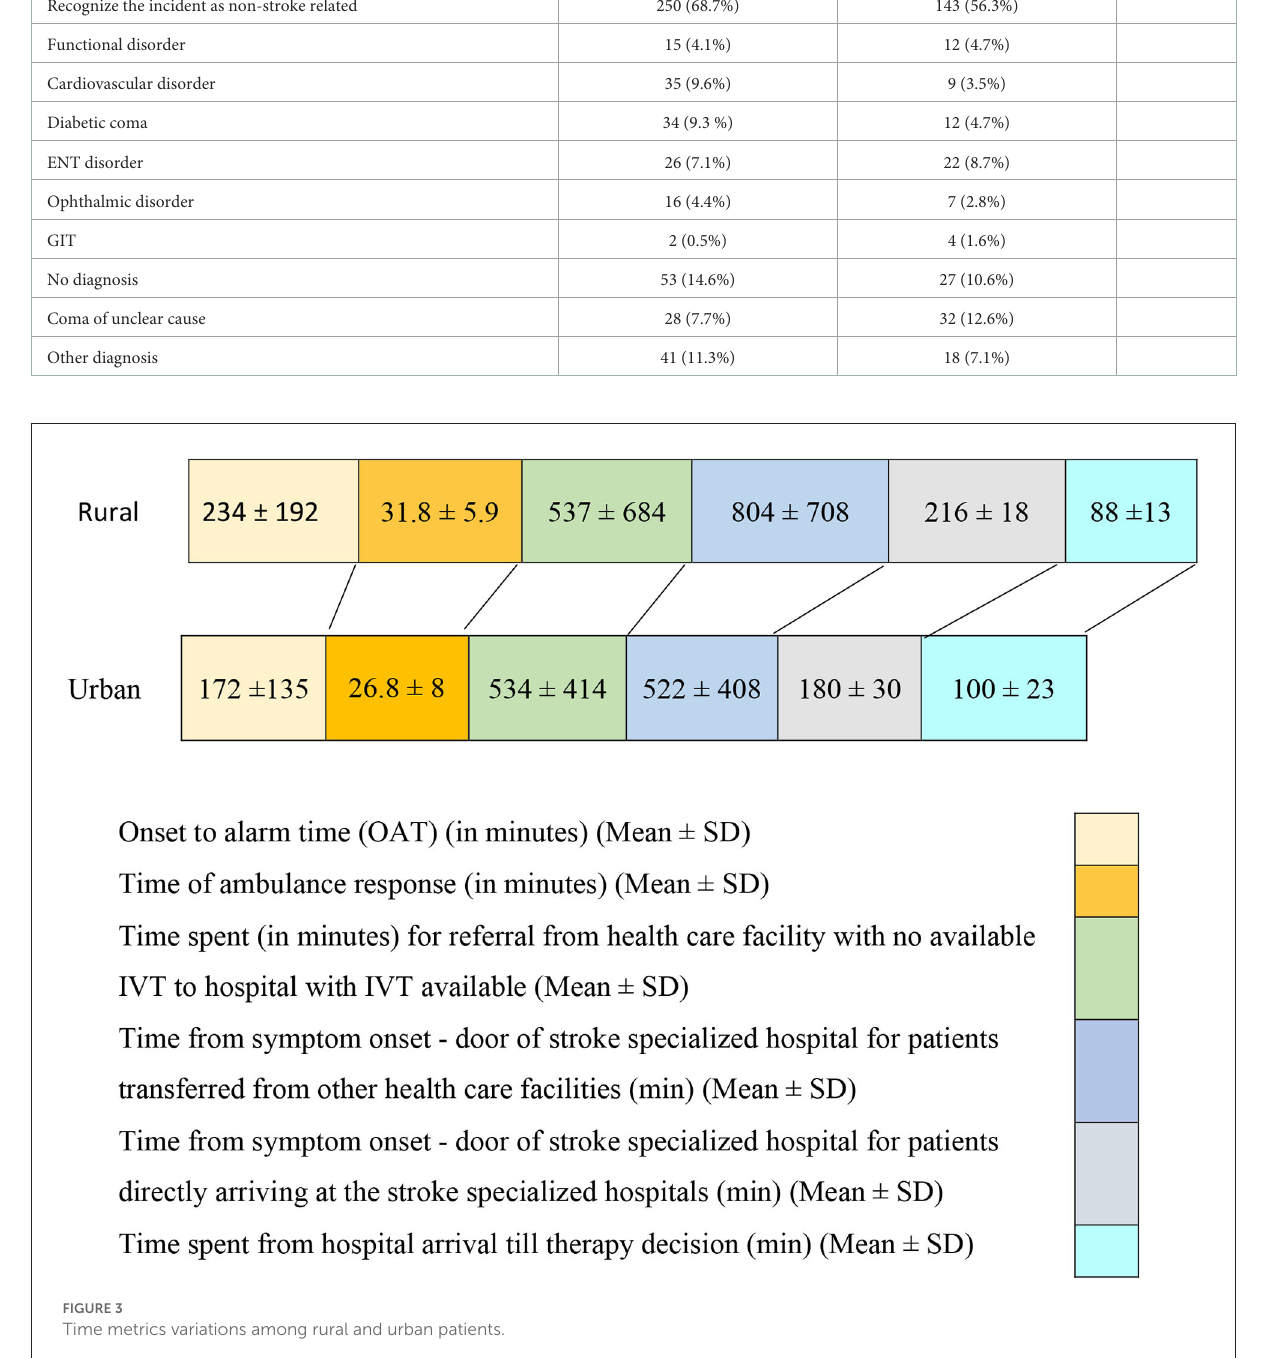
patients with stroke presenting outside the time window in comparison to urban patients was reported (9). Another study showed a proportion as low as 26.4% of urban patients